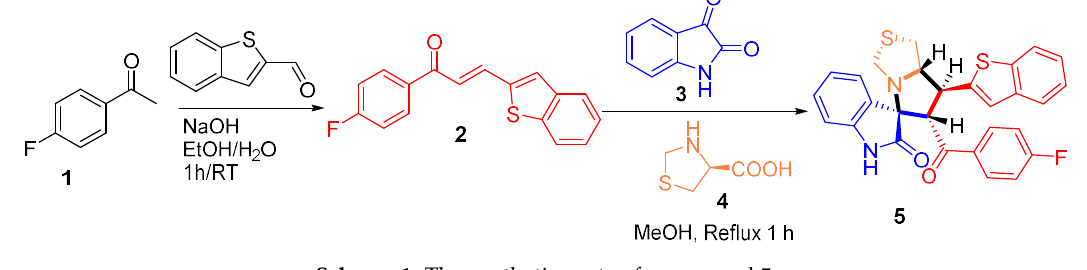
Scheme 1: The synthetic route of compound 5 .